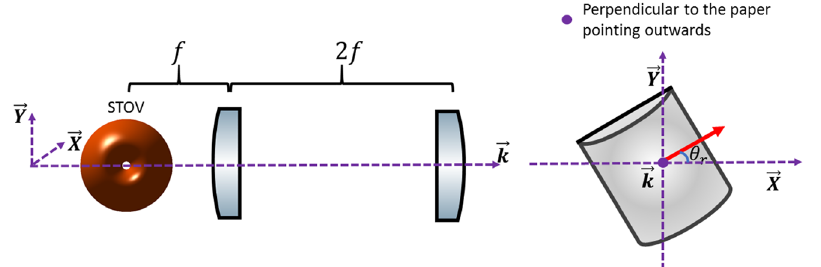
with respect to r